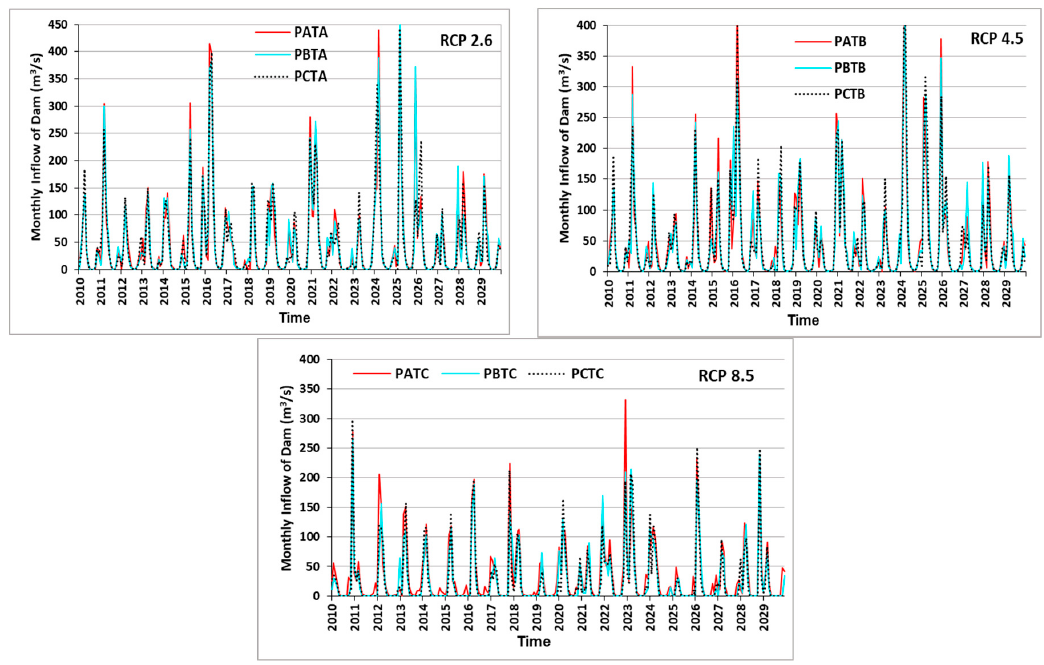
Figure 9. SWAT-simulated future monthly inflows at Boukan Dam for nine climatic scenarios, i.e., RCP 2.6 ( top left panel ), RCP 4.5 ( top right panel ) and RCP 8.5 ( bottom panel ) for precipitation (PA, PB, PC, see text for details) and temperature (TA, TB, TC, see text for details).